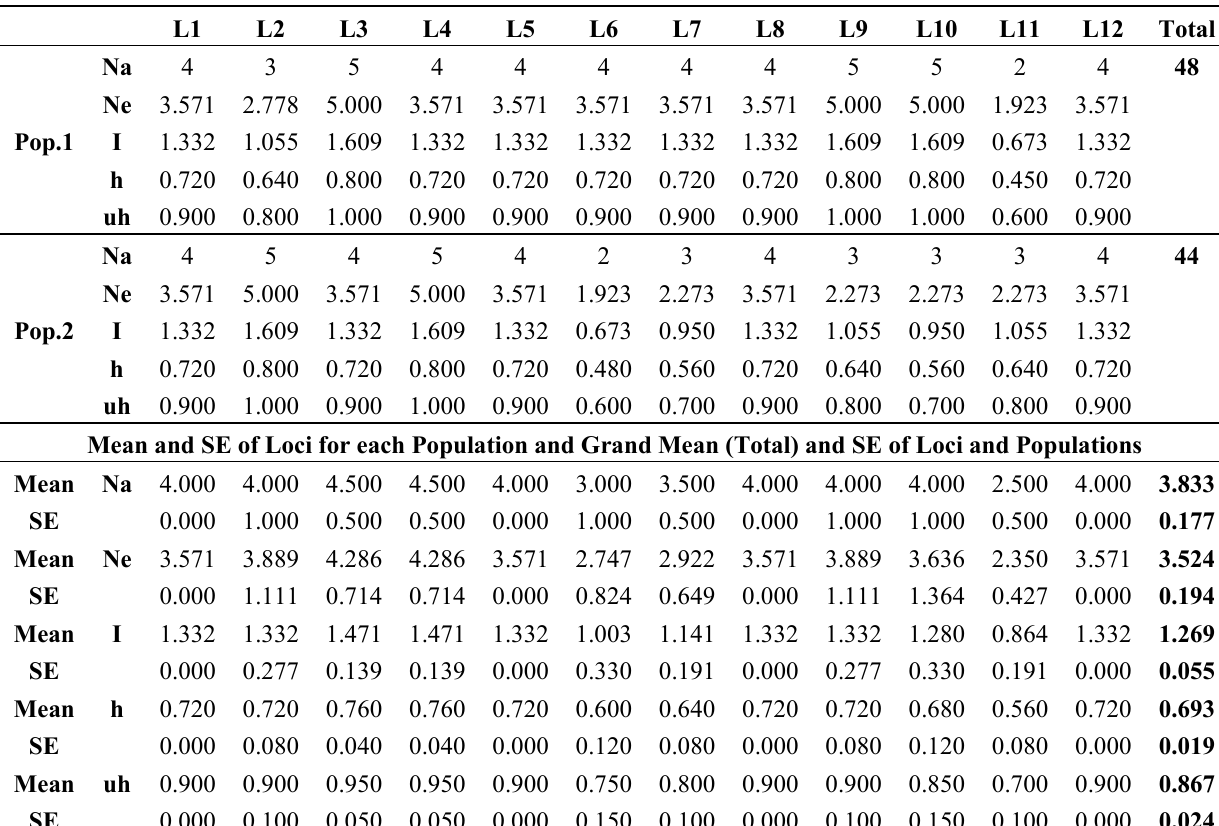
Table 4. Haploid diversity by locus. Number of loci = 12, number of samples = 10 (5/5), number of populations = 2. Na = number of different alleles; Ne = number of effective alleles (= 1/(Sum pi 2 )); I = Shannon’s information index (= 1 − Sum (pi × Ln (pi))), h = diversity (= 1 − Sum pi 2 ); uh = unbiased diversity (= (N/(N − 1)) × h), where pi is the frequency of the ith allele for the population and Sum pi 2 is the sum of the squared population allele